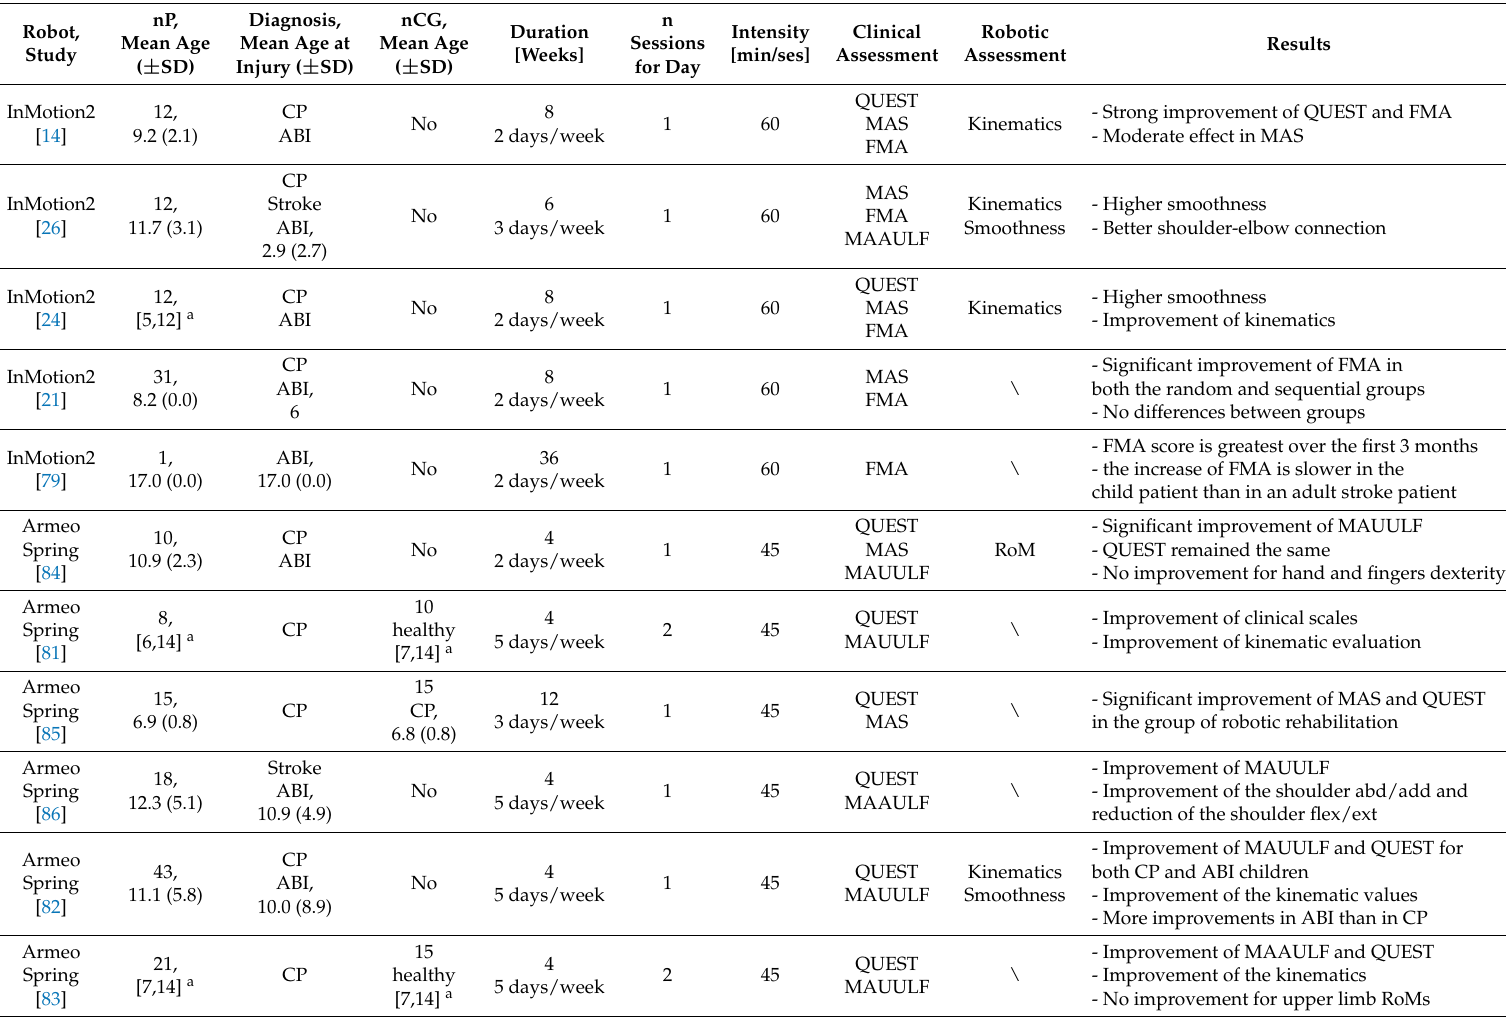
Table 2. Clinical protocols. nP: number of patients; nCG: number of control group subjects. a indicates the age